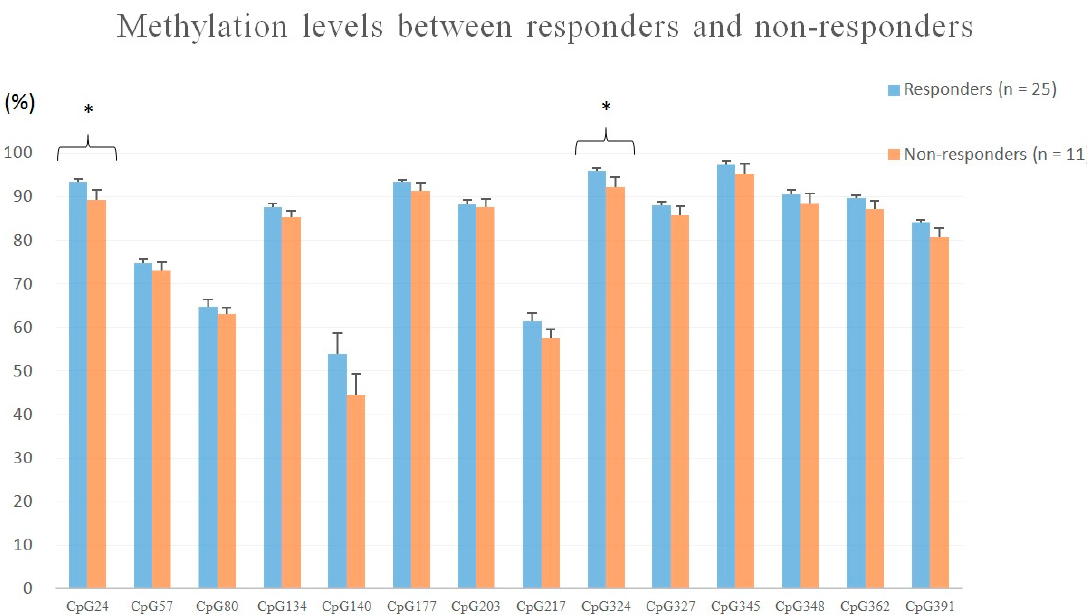
Figure 1. Methylation levels of 14 CpG sites of BDNF exon IX in patients with MDD and the healthy controls. (* p < 0.05)